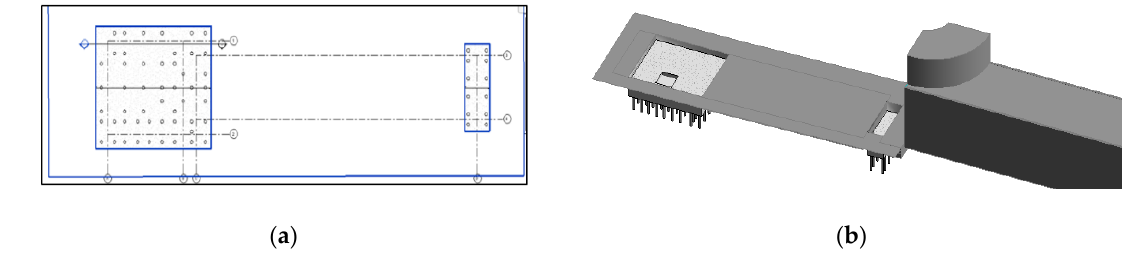
Figure 3. Foundations model: ( a ) top view; ( b ) 3D view.